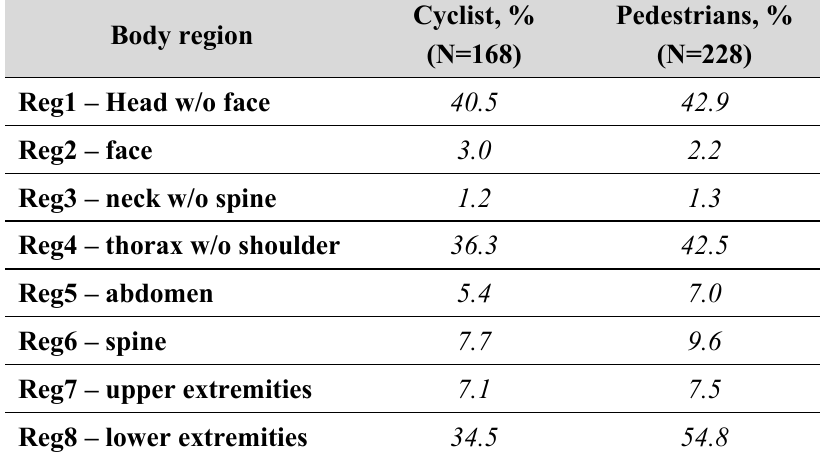
Table A4. Proportion of MAIS3+ injured cyclists and pedestrians sustaining MAIS3+ injuries in the listed body regions